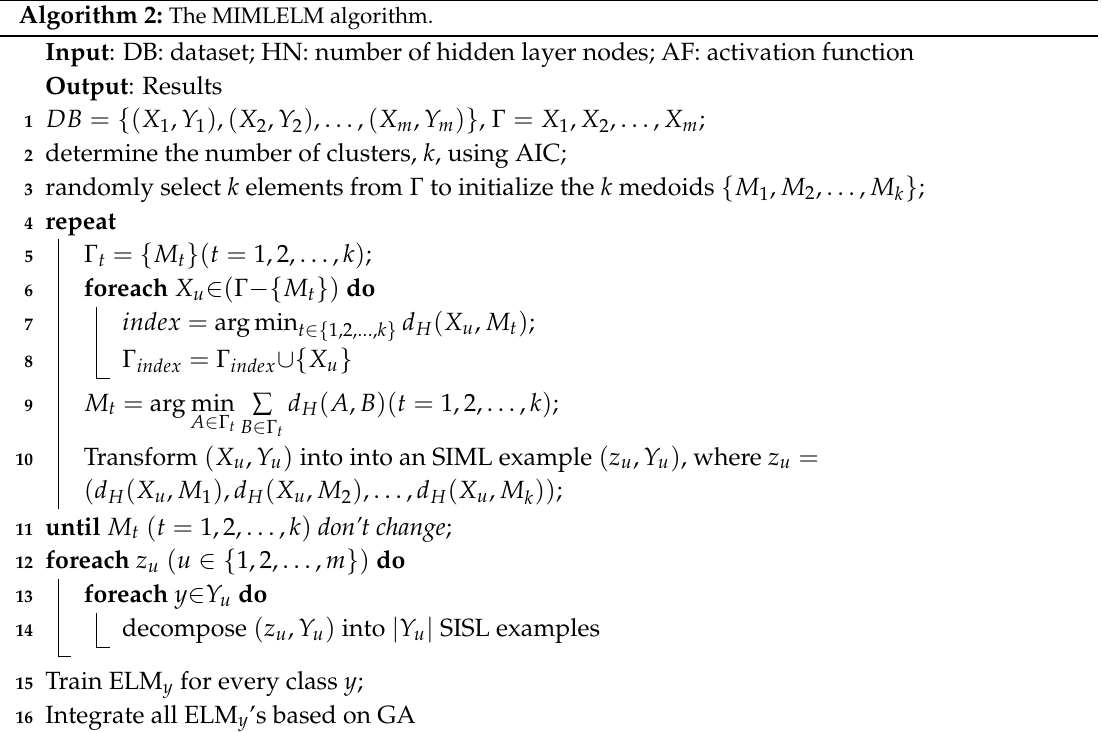
Algorithm 2: The MIMLELM